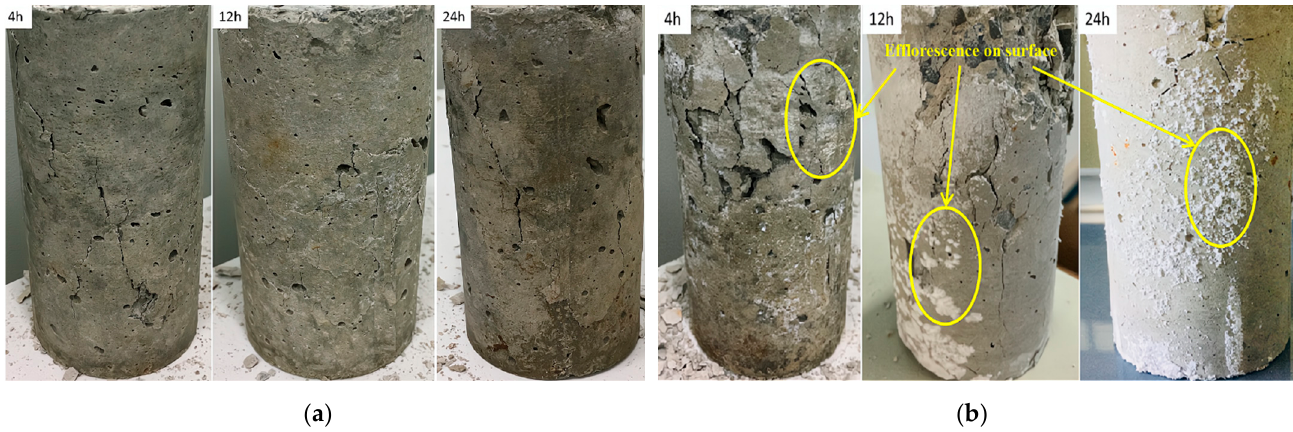
Figure 6. The failure of the samples under uniaxial compression: ( a ) uniaxial compression failure of samples without sulfate solution; ( b ) uniaxial compression failure of samples with 10% concentration sulfate solution.